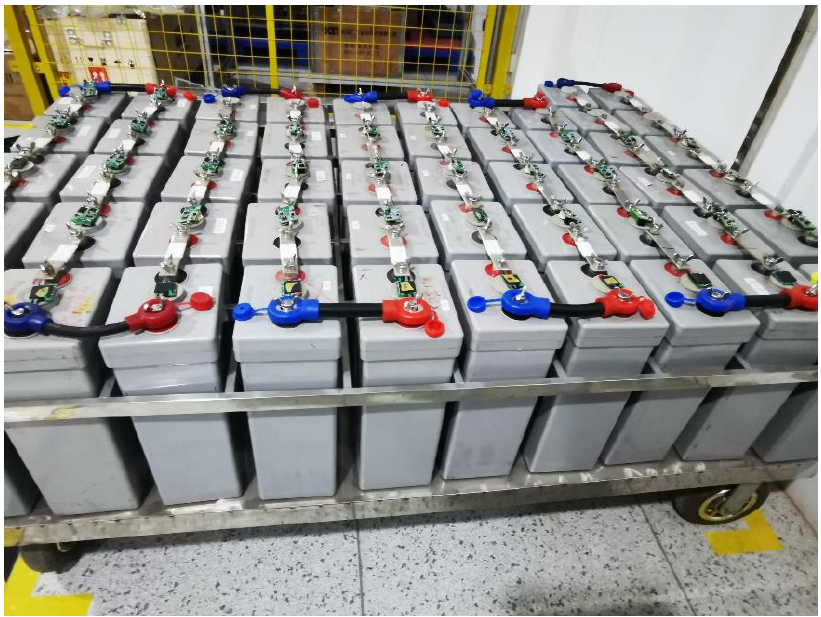
Figure 11. Physical picture of experimental batteries. Sensors 2020 , 20 , x FOR PEER REVIEW